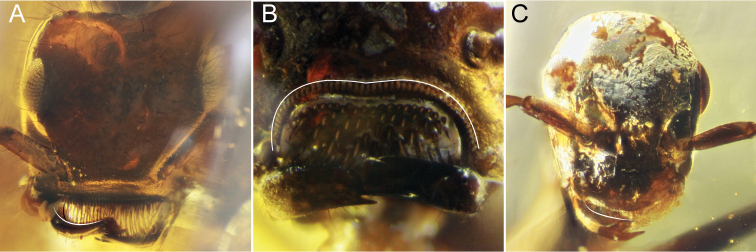
Facial views of †Zigrasimeciinae stat. nov. and †Sphecomyrminaesensu strictoA †Zigrasimecia species, worker, posterodorsal oblique (ANTWEB1032623) B †Zigrasimecia species, worker, anterodorsal oblique (ANTWEB1032660) C †Gerontoformica species, worker, dorsal (ANTWEB1032649).